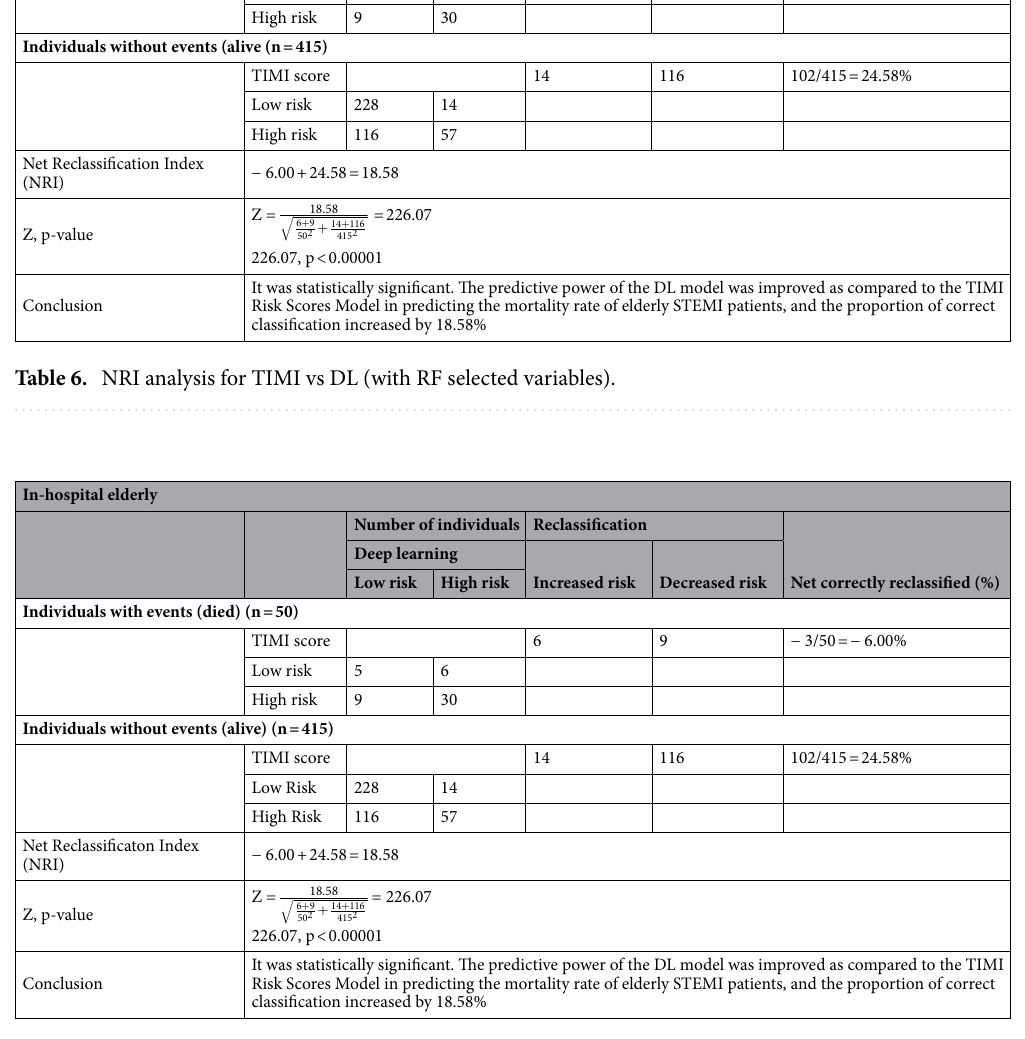
Table 7. NRI analysis TIMI vs DL (with XGB selected